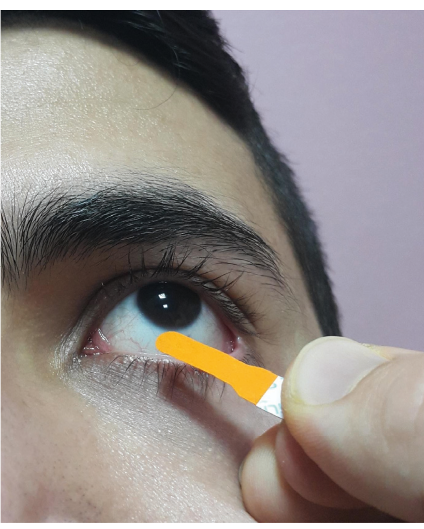
Figure 3: Fluorescein strip